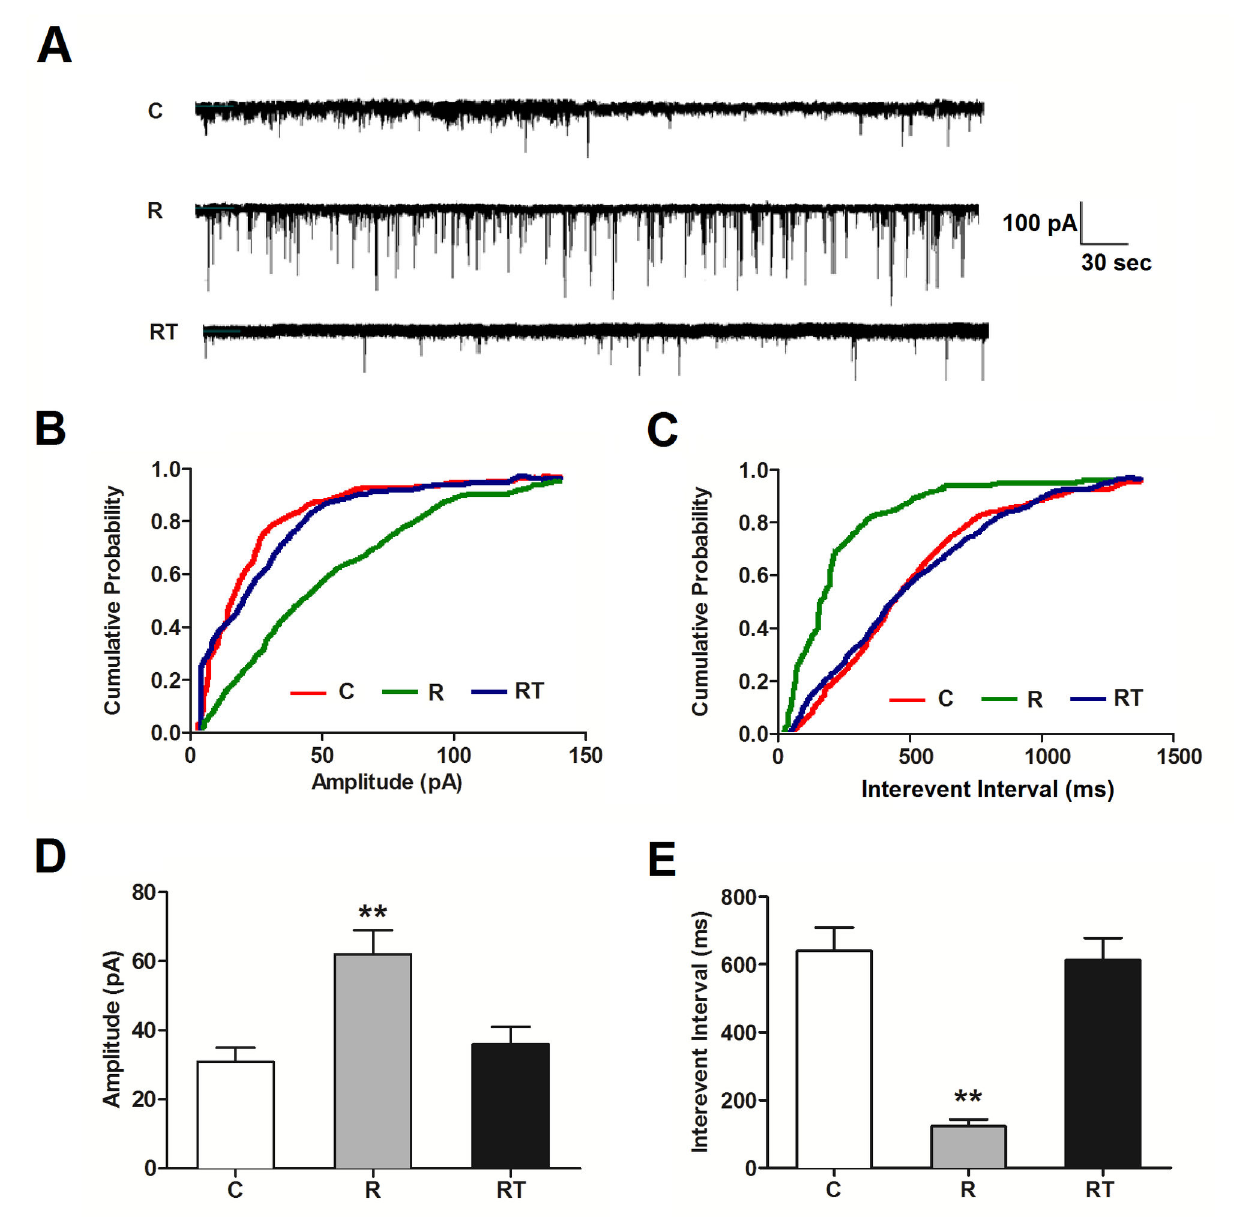
Figure 4. GSK-3β inhibition prevents the enhancement effect of remifentanil on NMDA receptor-mediated mEPSCs in dorsal horn neurons. NMDA receptor-mediated mEPSCs in dorsal horn neurons were recorded at the holding potential of -70mV in the presence of TTX (10 μM), GABA receptor antagonist bicuculline (BIM, 20 μM) and AMPA receptor antagonist CNQX (20 μM). Representative traces of mEPSCs under control conditions (C group) and Remifentanil (R group) and Remifentainil+TDZD-8 treatment (RT group) were showed in A. Scale bar , 100 pA, 30 s. Cumulative probability plots of mEPSCs amplitude distribution showed significant shift after remifentanil treatment in spinal dorsal horn neurons (Kolmogorov-Smirnov test, P < 0.01), but no shift after Remifentainil+TDZD-8 treatment (Kolmogorov-Smirnov test, P = 0.881), (B). The distribution of cumulative interevent intervals (IEIs) for mEPSCs showed significant shift after remifentanil treatment in spinal dorsal horn neurons (Kolmogorov-Smirnov test, P < 0.01), however there is no shift after Remifentainil+TDZD-8 treatment (Kolmogorov-Smirnov test, P = 0.932), (C). Summary bar graph of mEPSCs amplitude in dorsal horn neurons treated with different treatments (D). n = 8 for each group, vs C group, ** P < 0.01, ANOVA. Bar graph of mEPSCs IEIs in dorsal horn neurons treated with different treatments (E). n = 8 for each group. vs C group, ** P < 0.01, ANOVA.